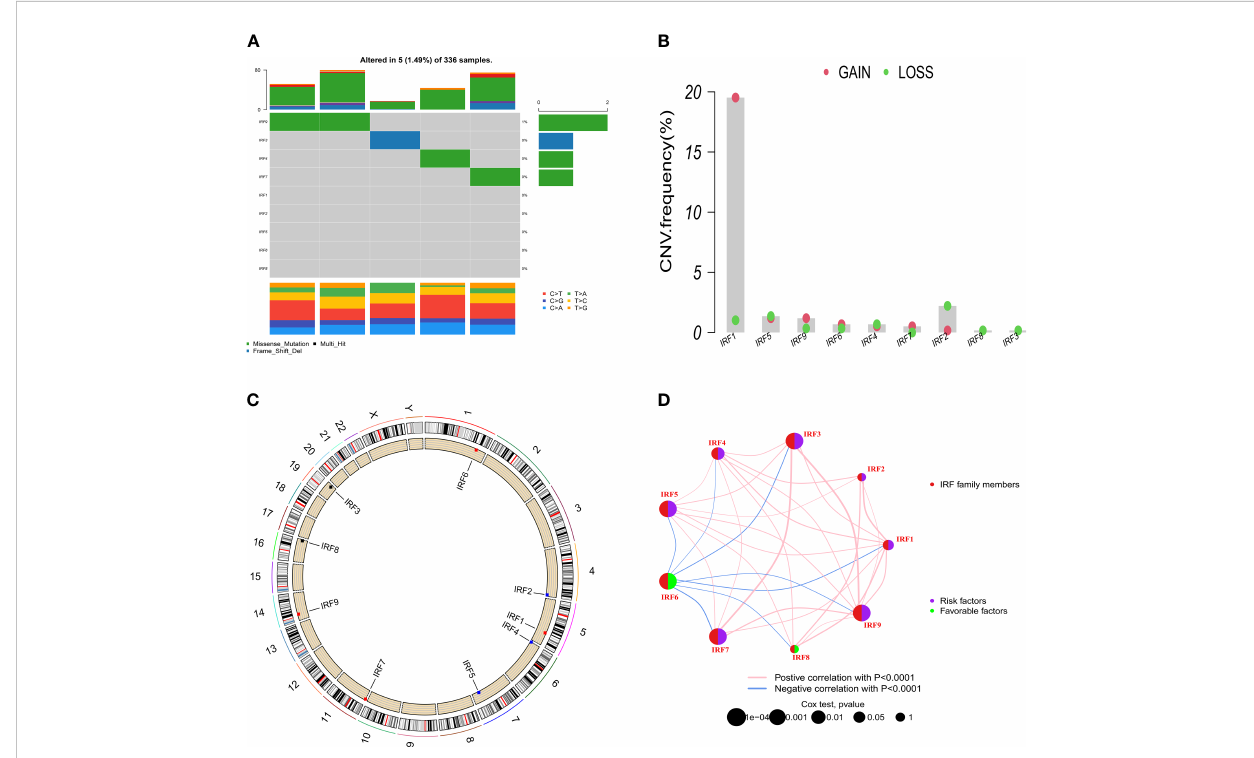
FIGURE 2 Somatic mutation and CNVs frequencies of the IRF family members in ccRCC. (A) Mutation frequency of the IRF family members in 336 patients with ccRCC. (B) CNVs of the IRF family members. (C) Locations of the CNV alterations of the IRF family members on 23 chromosomes. (D) Correlations and prognosis of the IRF family members in ccRCC